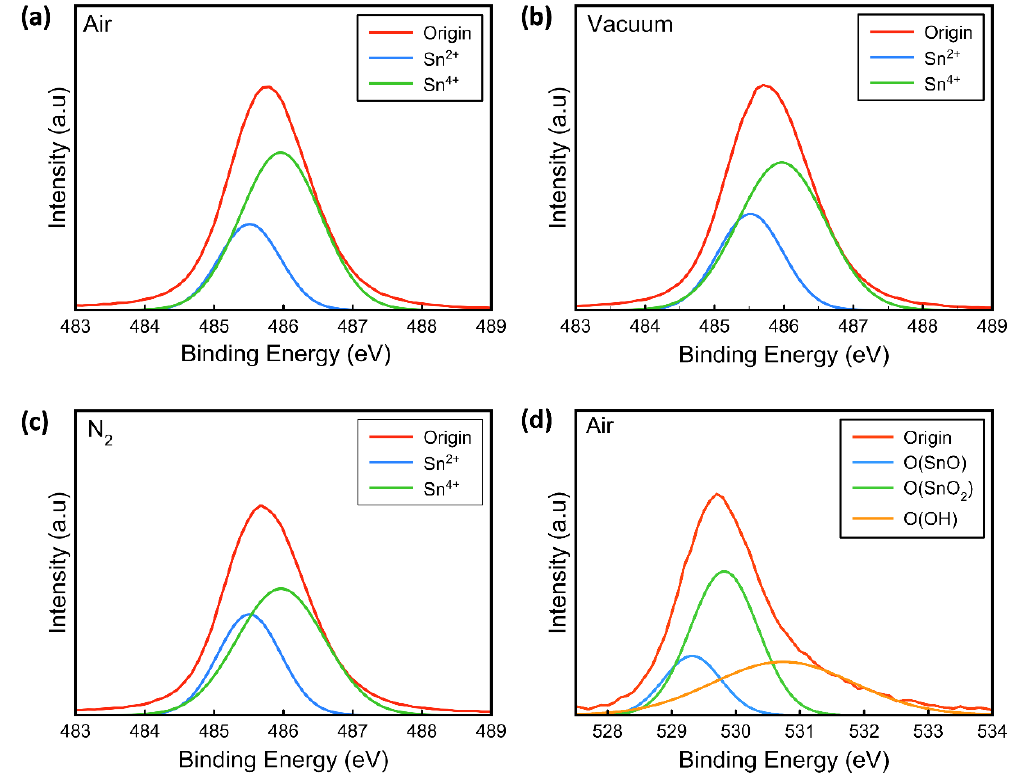
Figure 1. ( a ) GIXRD patterns and ( b ) calculated crystalline sizes of the SnO 2 films annealed in air, vacuum, and N 2 . The inset shows the SPM